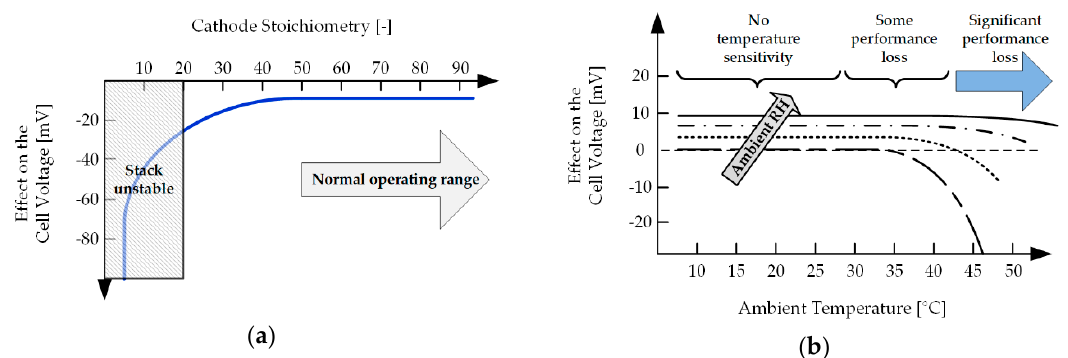
Figure 2. Effect of ( a ) the stoichiometric flow ratio and ( b ) of the ambient relative humidity and temperature on the performance of an air-cooled fuel cell stack. Adapted from Reference [4] with permission from Ballard Power Systems, January 2019.